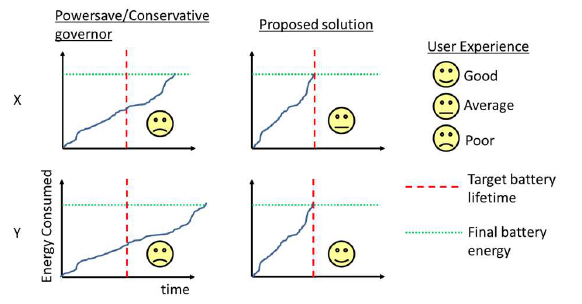
Figure 1. Illustration of motivating